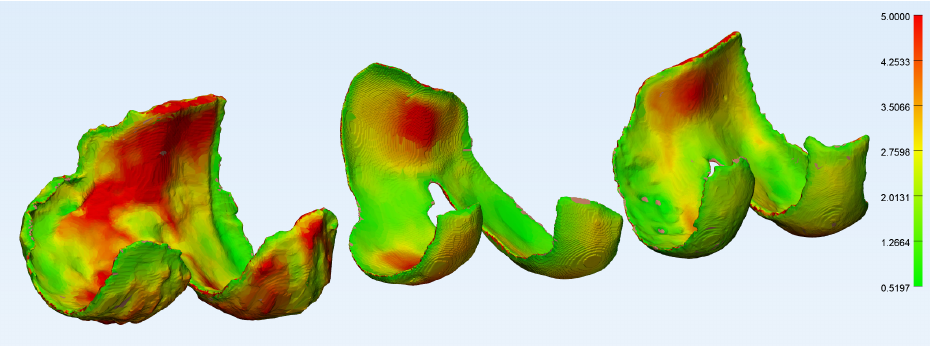
Figure 5. The wall thickness analysis of a femoral cartilage in 3-Matic, degenerative group ( left ), traumatic group ( center ) and control group ( right